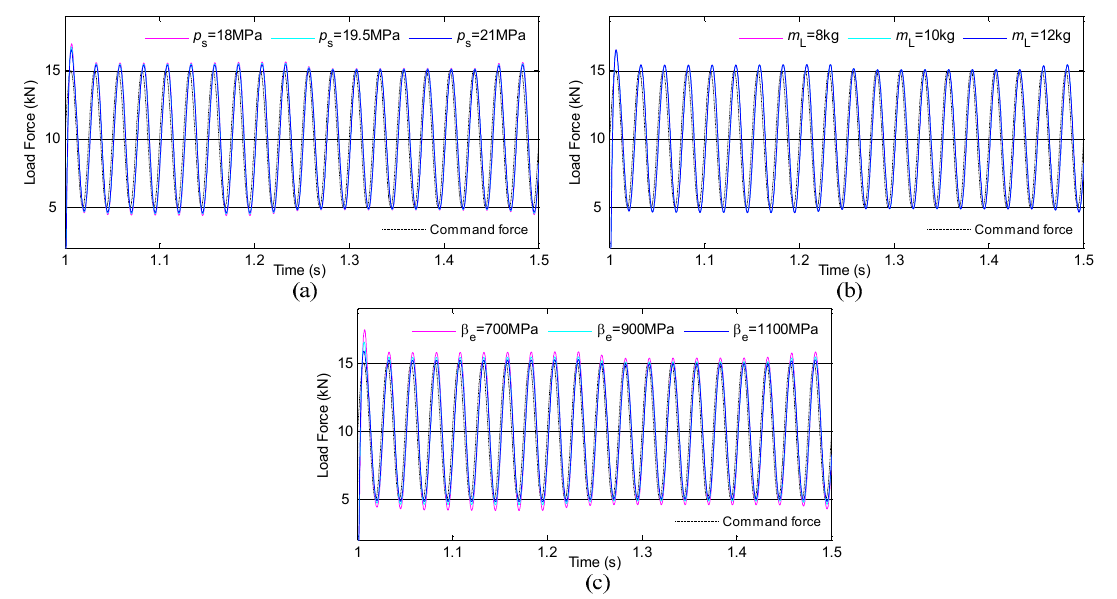
Figure 20. The loading performance of loading force 10 ` 5sin80 π t p kN q , ( a ) with perturbation of p s ; ( b ) with perturbation of m L ; ( c ) with perturbation of β e .